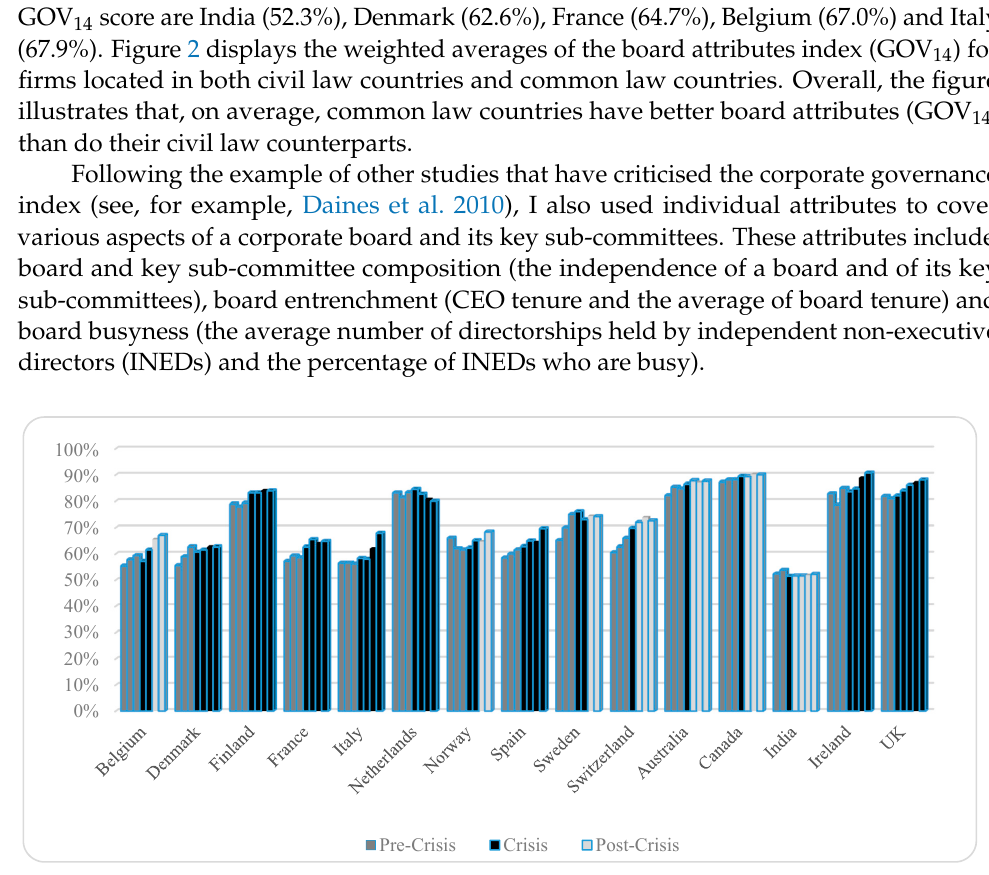
Figure 1. Board Attributes Index (GOV 14 ) by Country and Year (2006–2012).